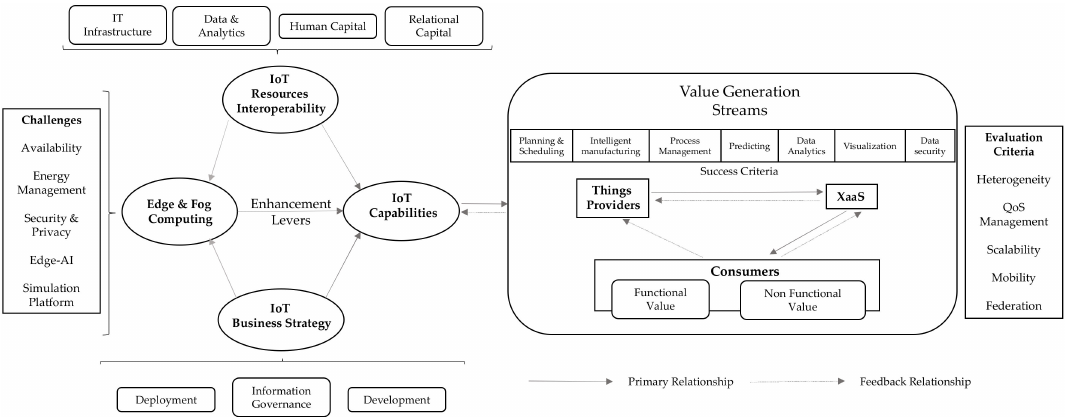
Figure 5. Conceptual